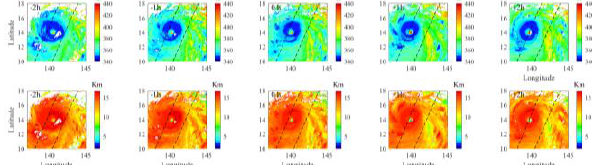
Figure 2. The detected cloud properties of “Mangkhut”. The upper row (lower row) is the cloud top temperature CTT (cloud top height, CTH)